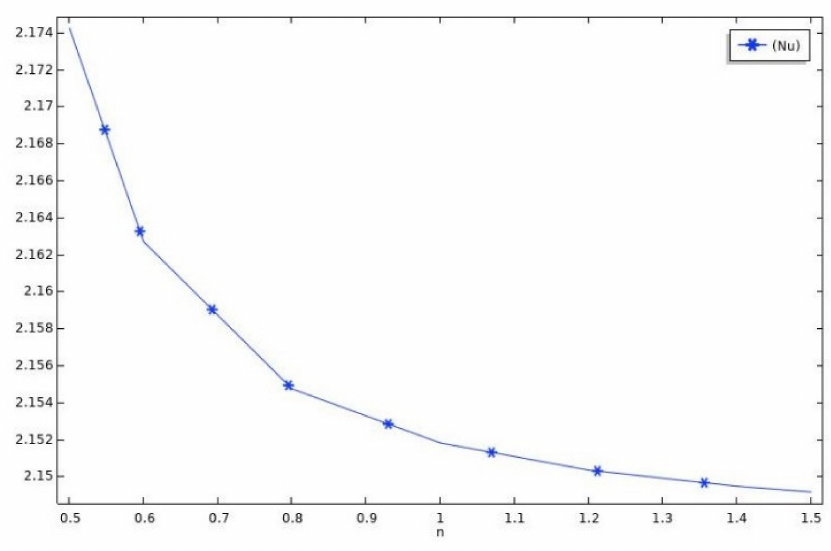
Figure 9. Nusselt number graph against varying ( n )